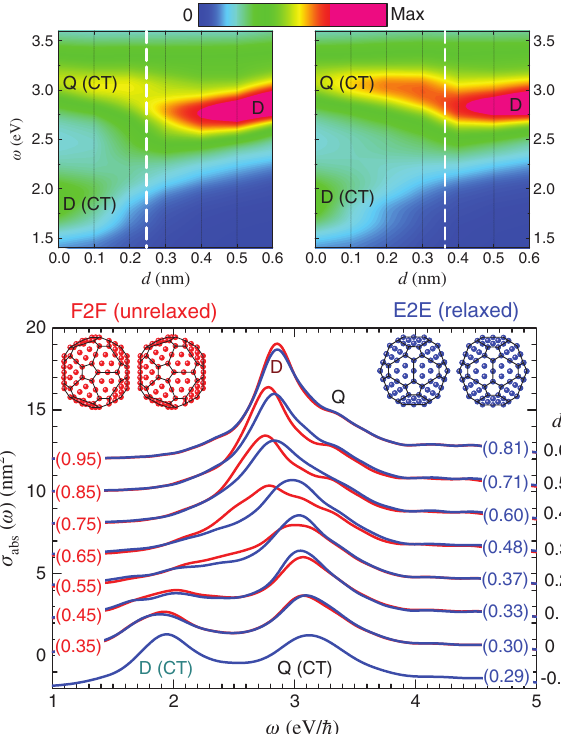
( ω ), of Na abs 297